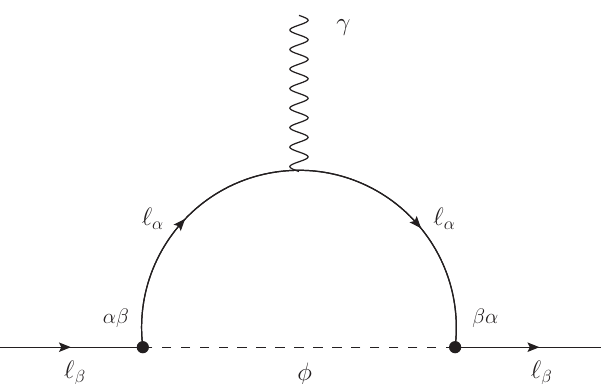
Figure 6 . Feynman diagram for the one-loop contribution to the anomalous magnetic moment of charged leptons given by the interaction in eq. (2.1). The flavor indices of the couplings contributing to the diagram have been specified in the vertices. The relation between these couplings, which we generically denote as C L,R and e C L,R , and the S L,R couplings in the effective Lagrangian of eq. (2.1) depends on the flavor states involved in the diagram. See text for a detailed